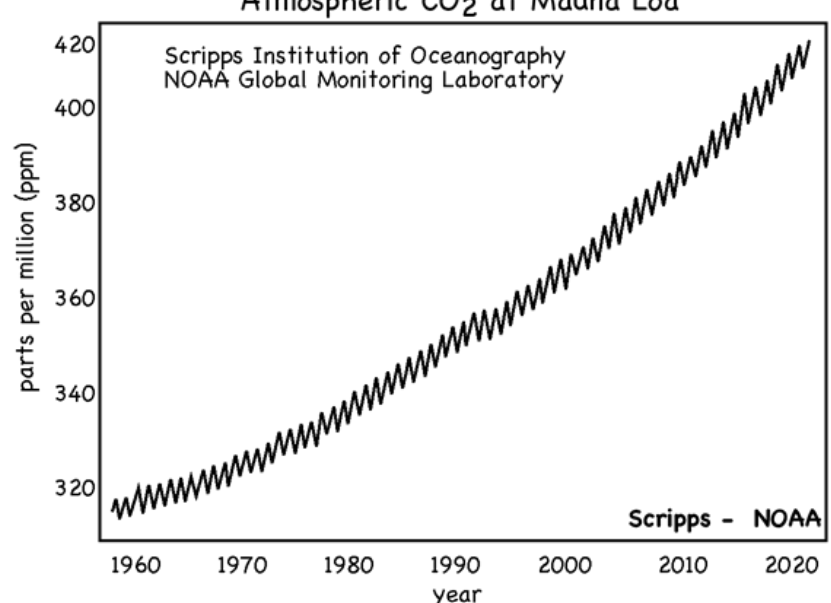
Figure 1. CO 2 concentrations in the atmosphere [7], started by C. David Keeling of the Scripps Institution of Oceanography in March 1958 [8]. (Adapted with permission from Scripps CO 2 program, Scripps Institution of Oceanography at UC San Diego, CA, USA.).